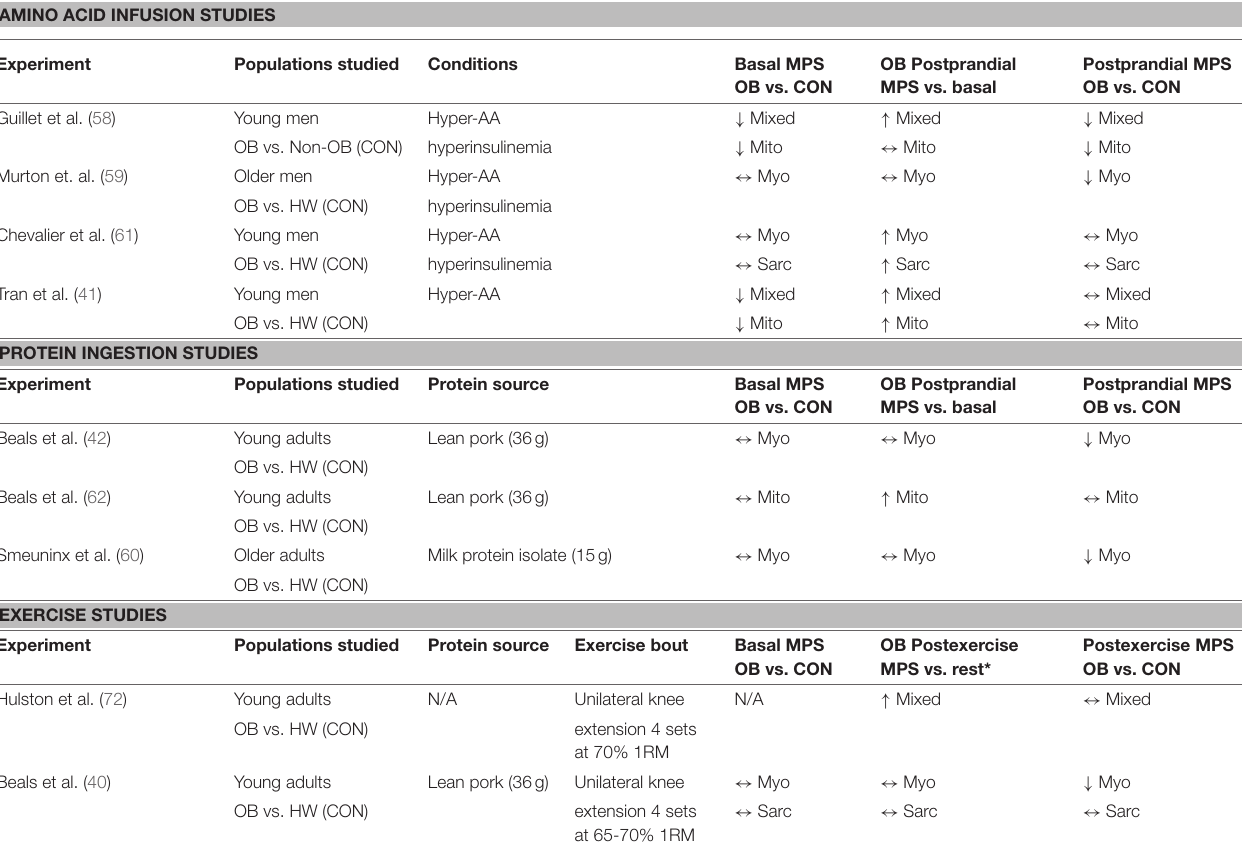
TABLE 1 | Effect of obesity on human muscle protein